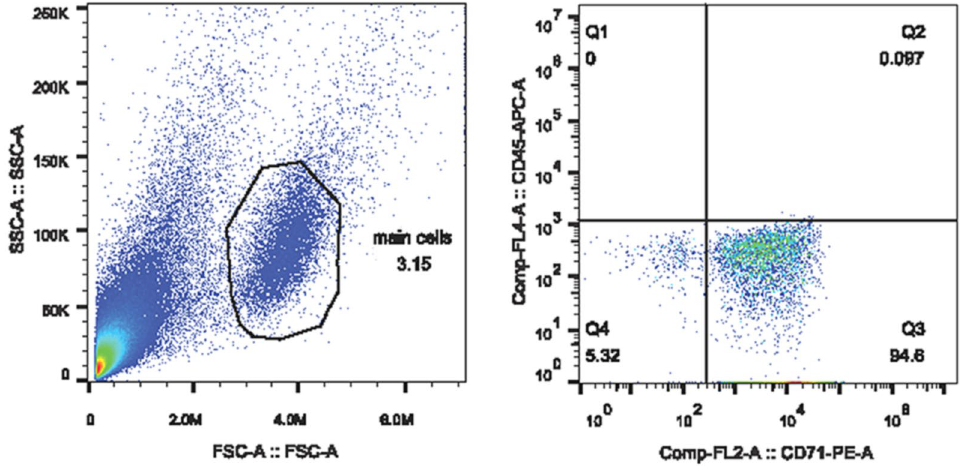
Figure 6. Confirmation of red blood cell sorting by fow cytometry. Aggregation of signals in the Q3 region is indicative of a mostly (94.6%) CD71 + cell